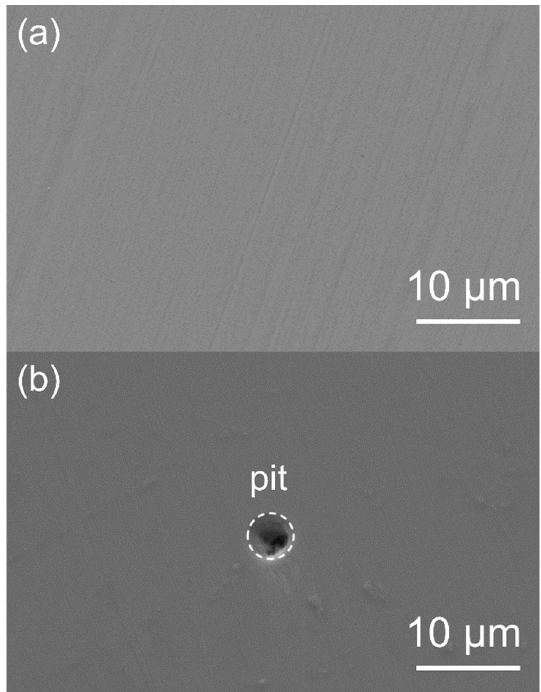
Figure 1. SEM pictures of the morphologies of LPBFed Ti–6Al–4V in Hank’s solution, at pH 3, after PP: ( a ) the surface without corrosion and ( b ) one pit was discovered on the surface of the sample.